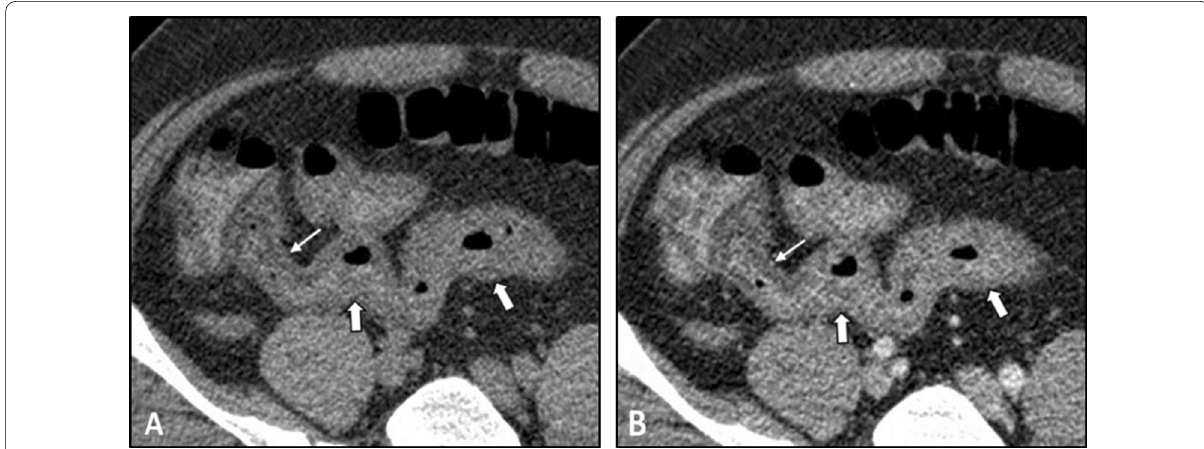
Fig. 11 Intestinal ischemia in a 37-year-old male with a history of known Henoch–Schönlein purpura (HSP) presenting with abdominal pain and bloody diarrhea. The patient underwent pre ( A )- and post ( B )-IV contrast CT scans using positive dilute oral contrast. Segmental mural thickening (thick white arrows) is seen in the terminal ileum with a focal area of mural hypoenhancement (thin white arrows) proximal to the ileocecal valve. Ileocolonoscopy confirmed mucosal ischemic changes, and signs/symptoms were improved following treatment by